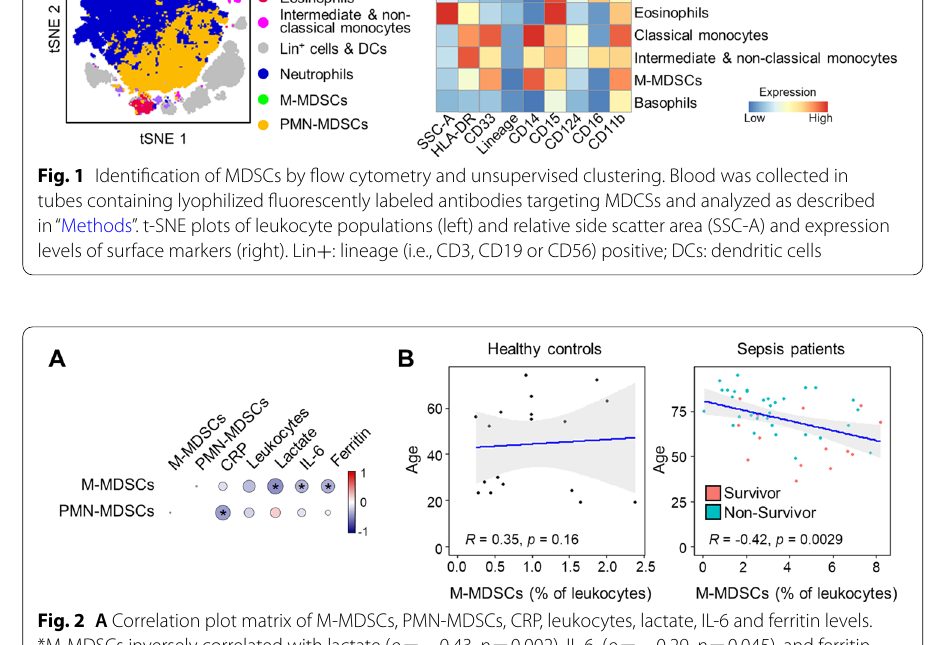
0.43, p 0.002), IL‑6, ( ρ 0.29, p 0.045), and ferritin = − = = − = 0.39, p 0.047). B Scatterplots of = − =